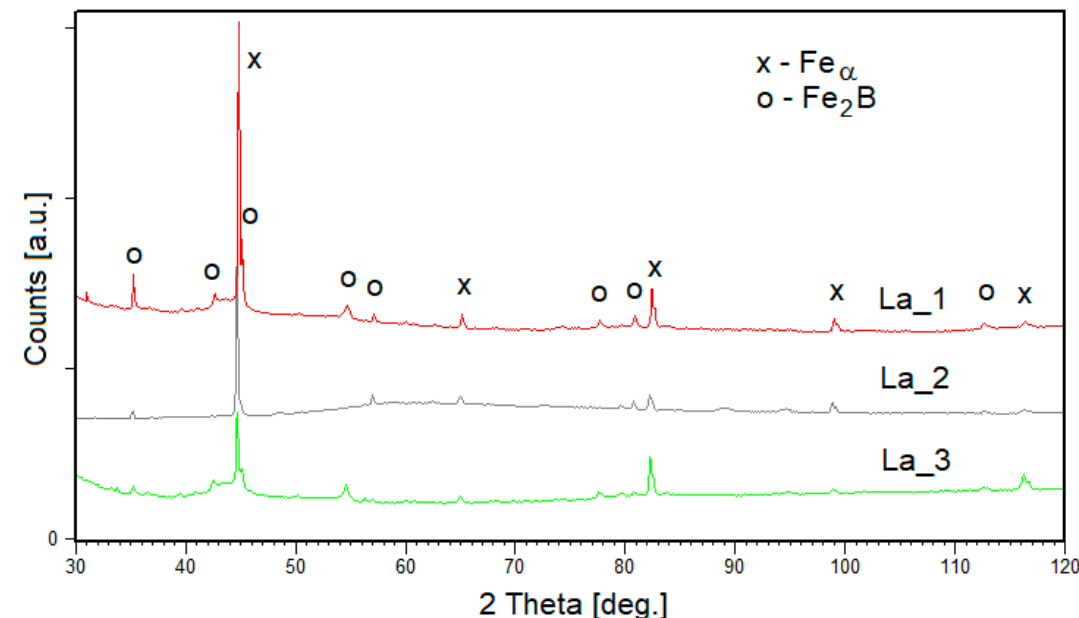
Figure 1. The X-ray diffraction patterns obtained for ingots of the Fe-B-La-Al marked with the La_1, La_2, and La_3, respectively. Table 2. Quantitative phase analyses of the main phases present in tested Fe-B-La-Al ingots (wt.%).